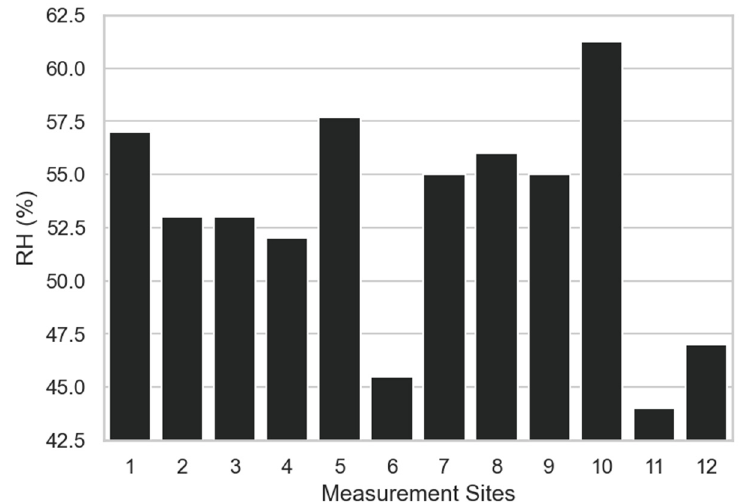
Figure 10. Air relative humidity at the measurement sites.